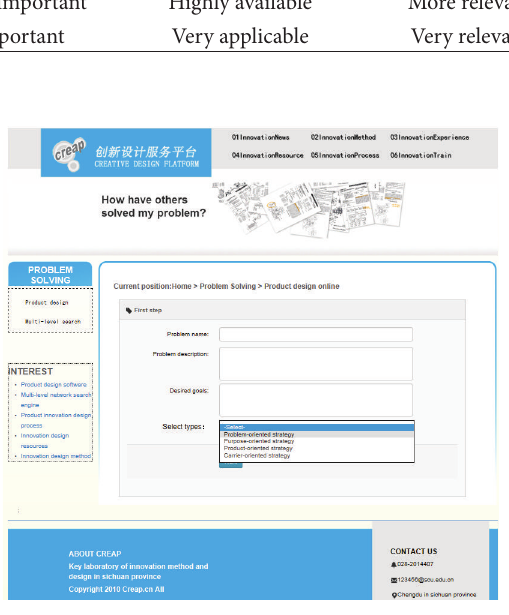
Figure 7: Interface of innovation